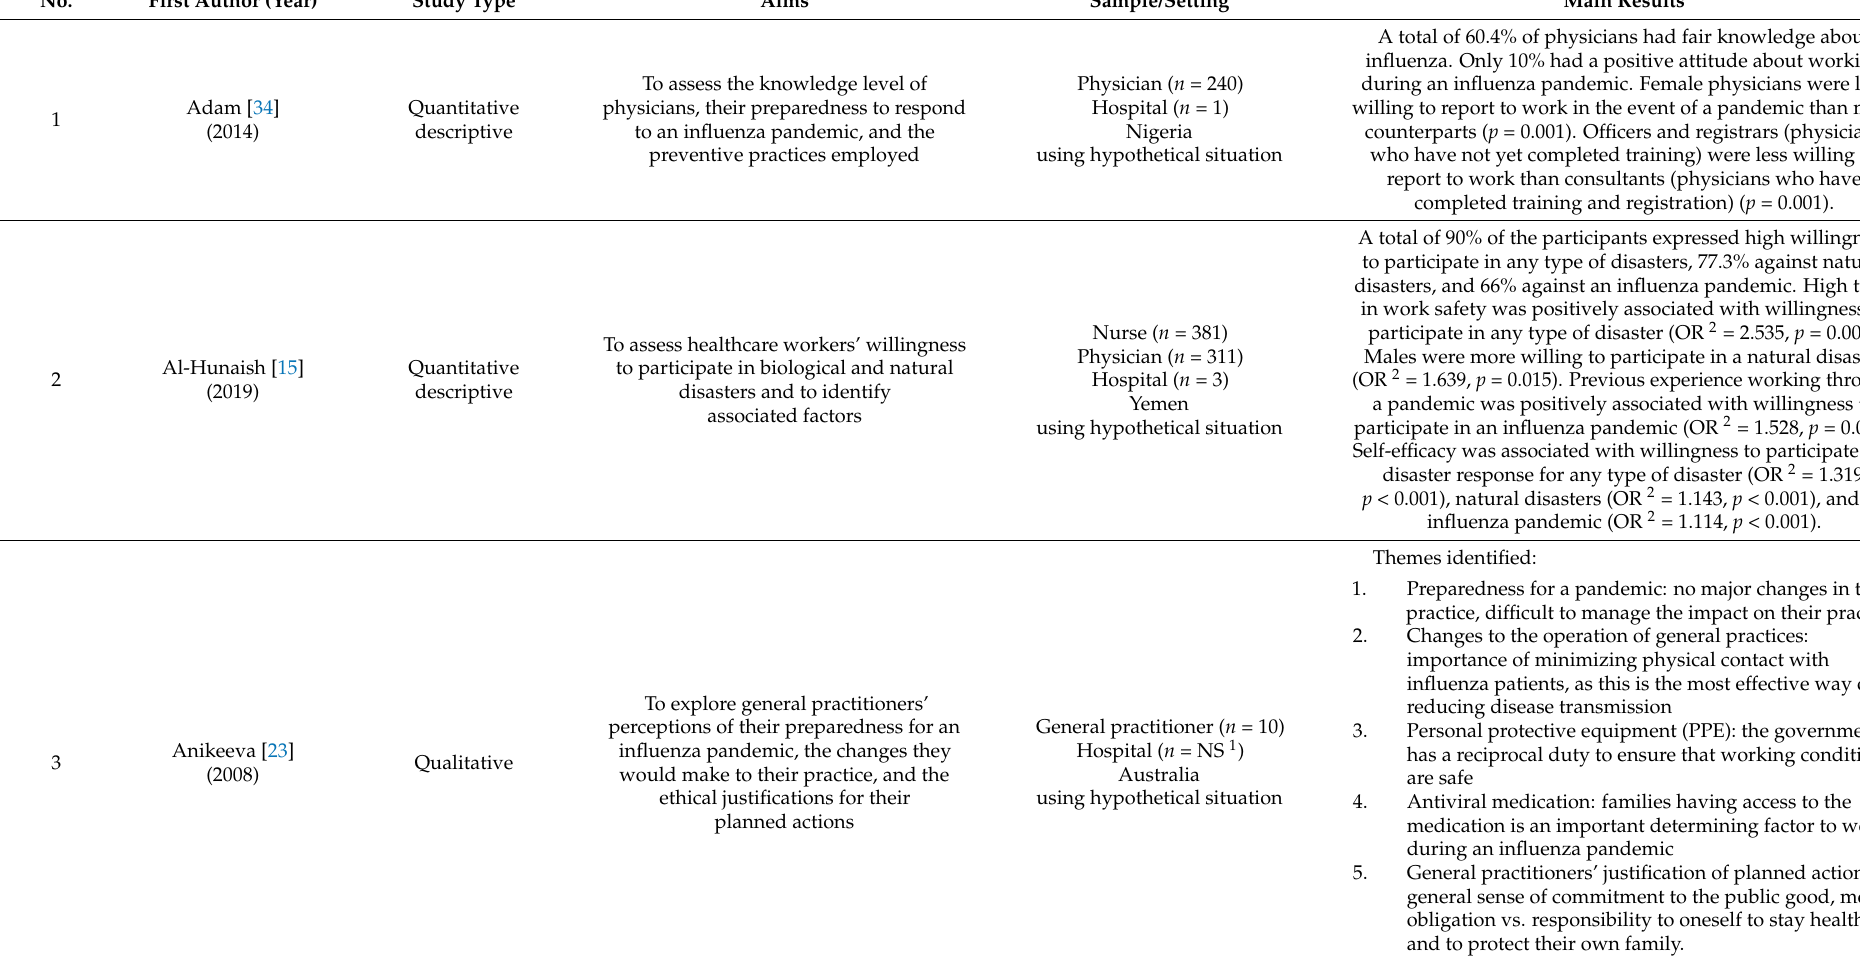
Table 1. Summary of Studies